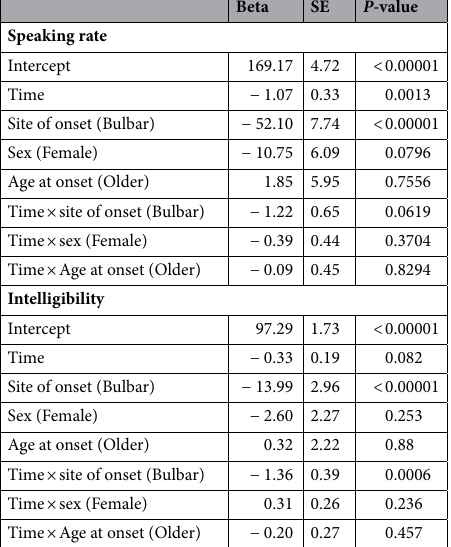
Table 3. LMEs model estimates accounting for the effect of site of onset, sex, age at onset, and their interactions with time (i.e., months relative to baseline) on functional speech measures.